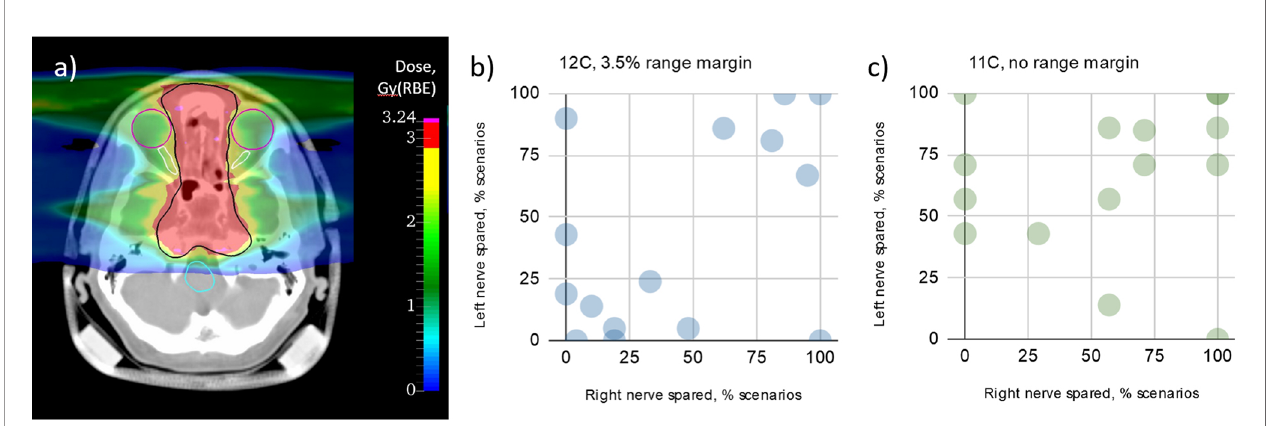
FIGURE 10 | Impact of range margin reduction in robust optimization on the optic nerves sparing for a set of ACC patients. (A) Example of CT and two- fi eld dose distribution for one of the analyzed patient plans. CTV, optic nerves, eyes and brainstem are contoured with black, white, purple and turquoise colors, respectively. Color bar represents the dose distribution (prescribed dose 3 Gy(RBE)). Primary goal of the robust optimization was achieving at least 95% of the prescribed dose in 95% of uncertainty scenarios (21 scenarios in total). Graphs represent sparing of left and right optic nerves in the analyzed plans with 12 C beams (B) (3.5% range and 3 mm setup margin) and 11 C plans (C) (3 mm setup margin only), respectively. Each point corresponds to a single patient case (15 patients